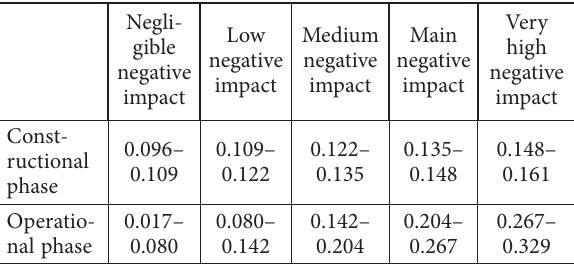
Table 6. Categories of environmental impact in two different phases